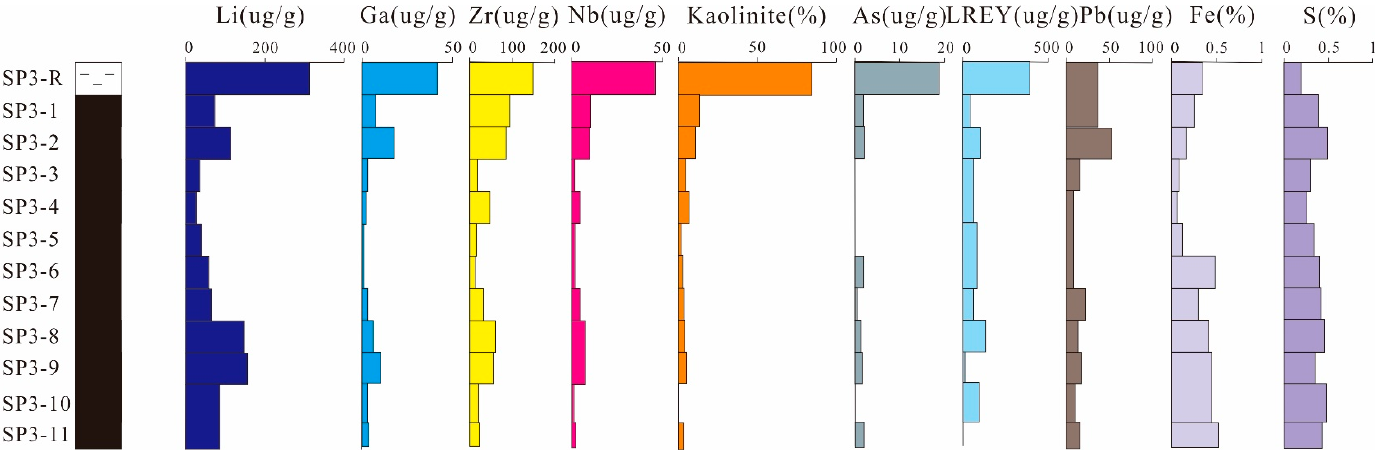
Figure 5. Vertical variation of concentrations of elevated elements and kaolinite content in the No. 3 coal from the Sangshuping coal mine.